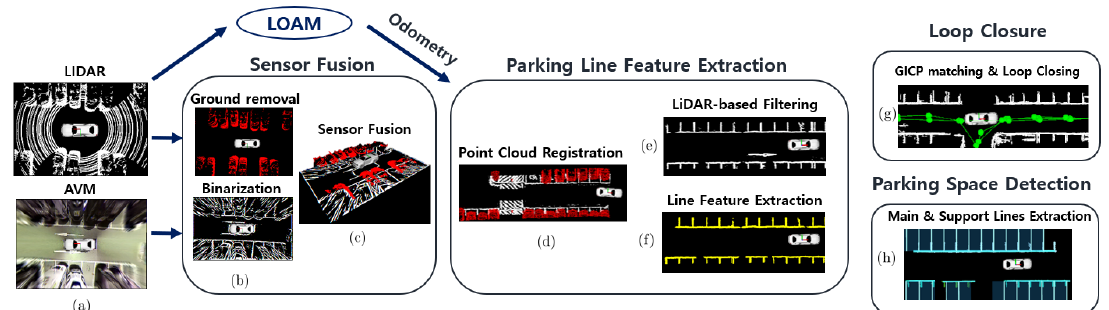
Figure 2. Process pipeline of the whole algorithm. Each module is executed